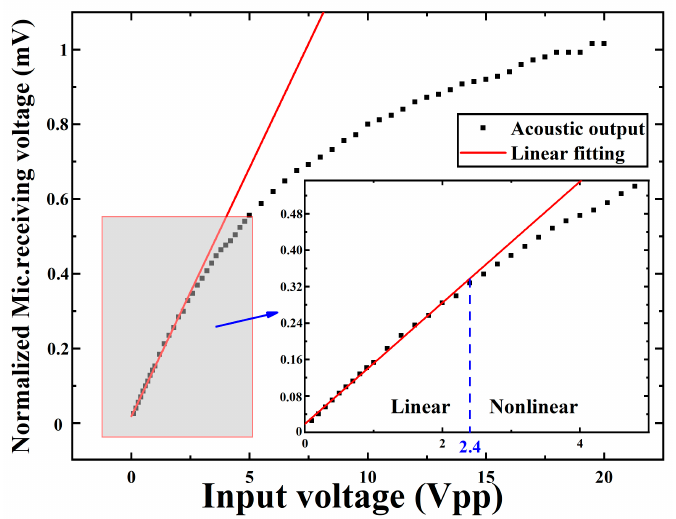
Figure 11. The acoustic output of PMUT under different voltages (0–20 V).